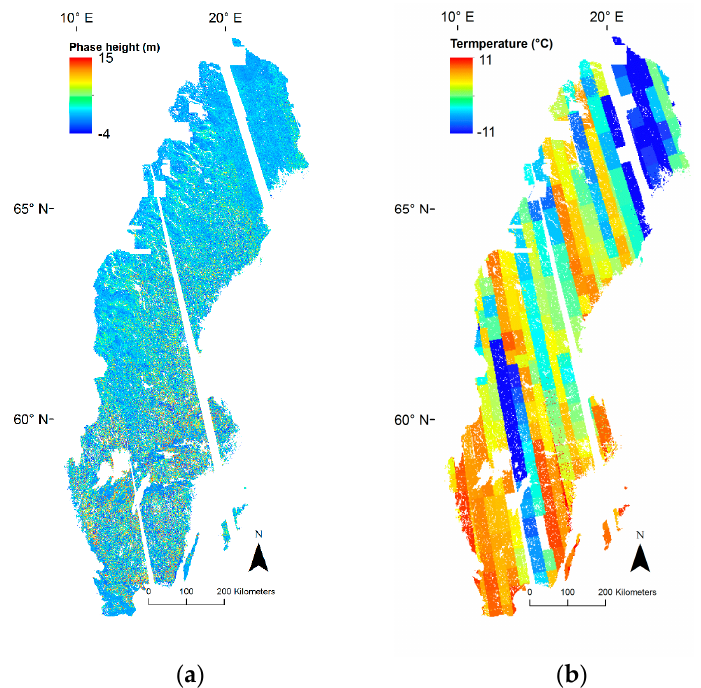
Figure 11. ( a ) Phase height mosaic. ( b ) Average ground scene temperatures.